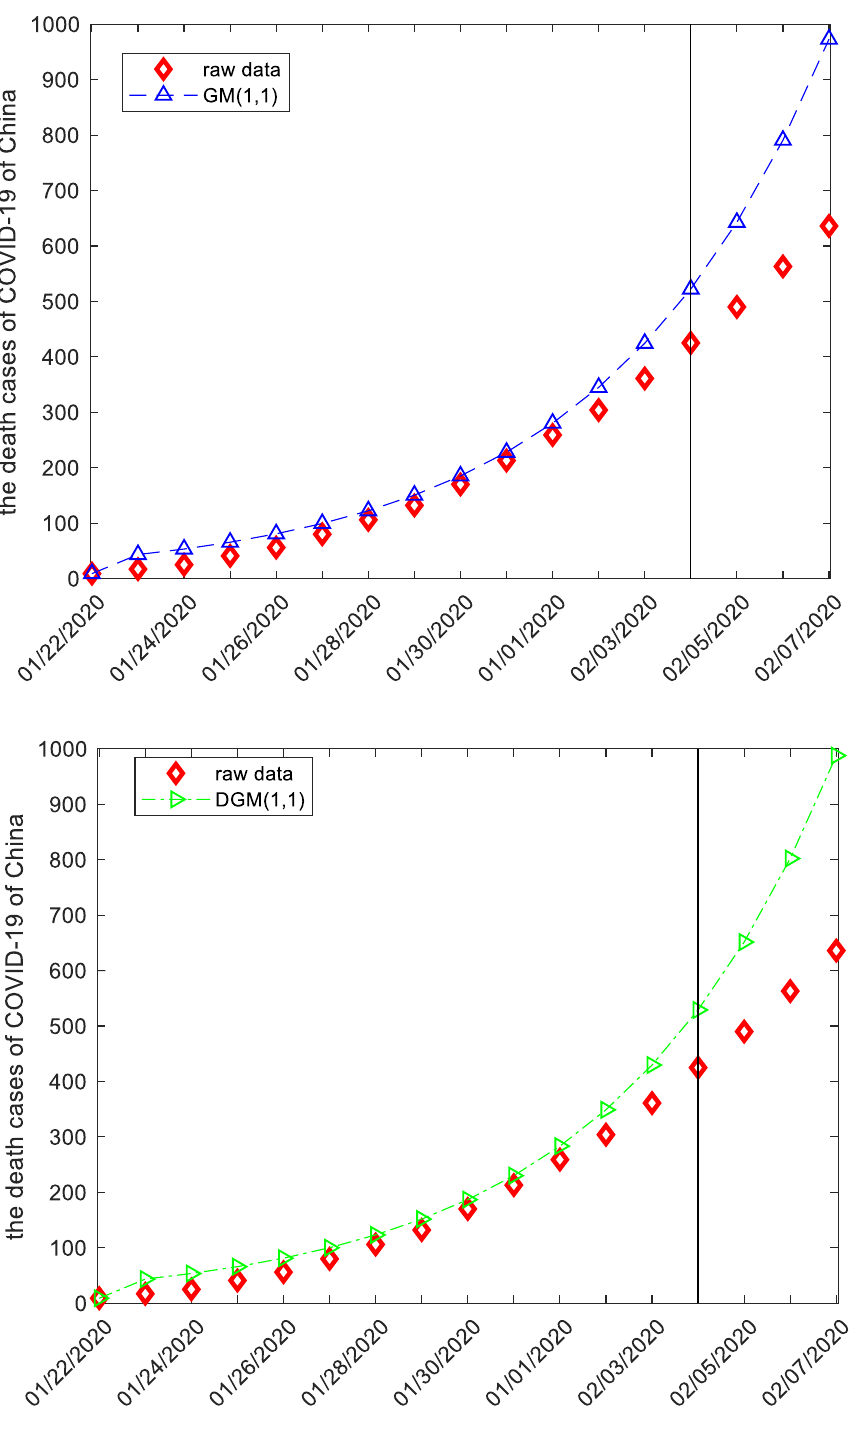
Figure 5. The plots of the death cases of COVID-19 of